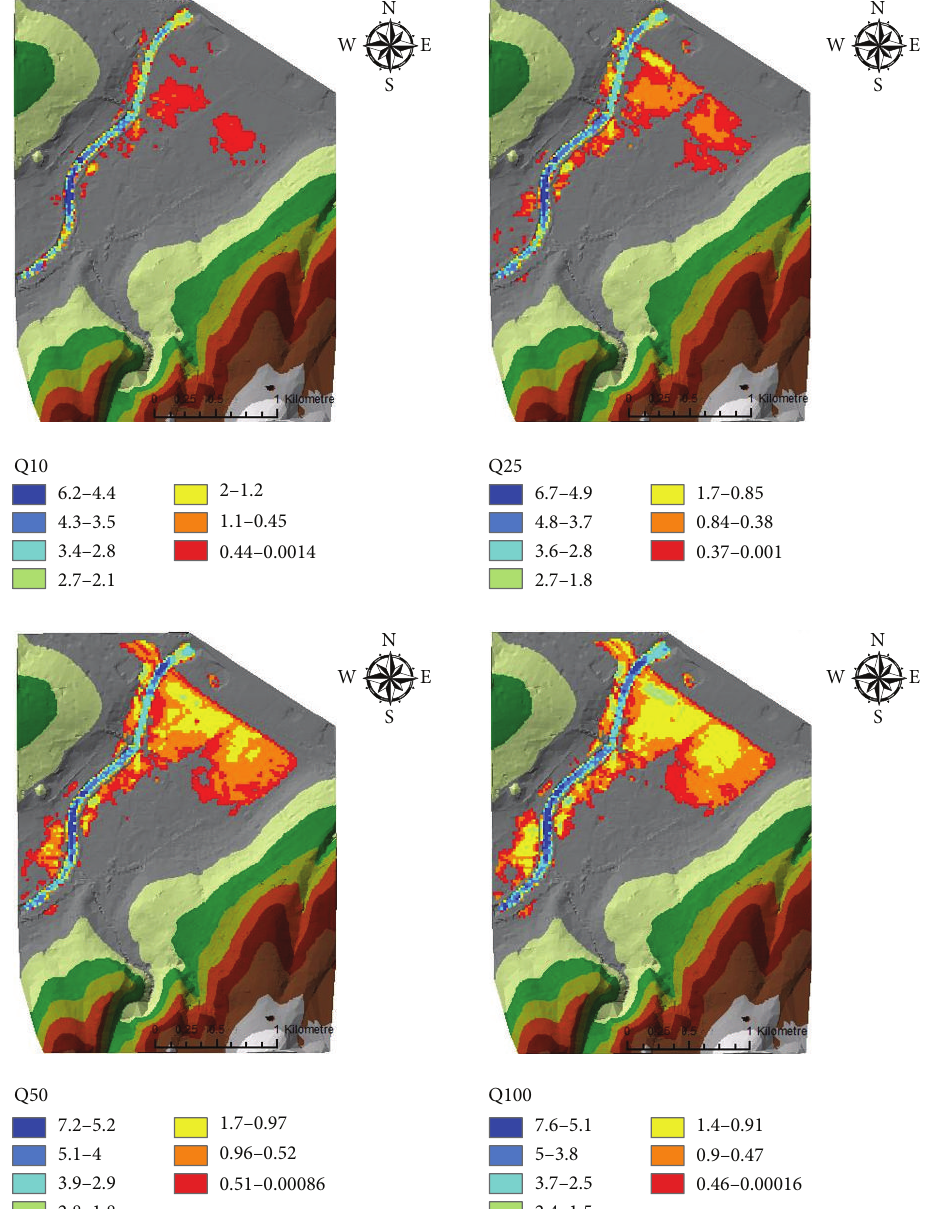
Figure 5: Water elevation maps of the studied area for the Q10, Q25, Q50, and Q100